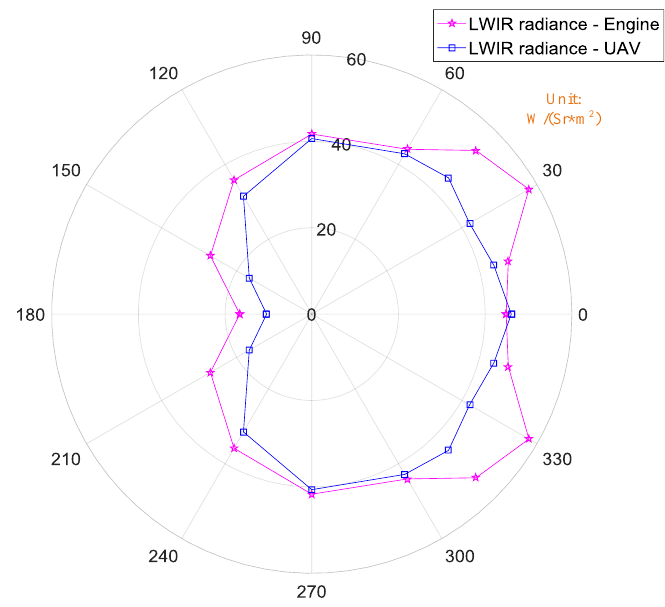
Figure 18. Comparison of LWIR radiance between engine and UAV.